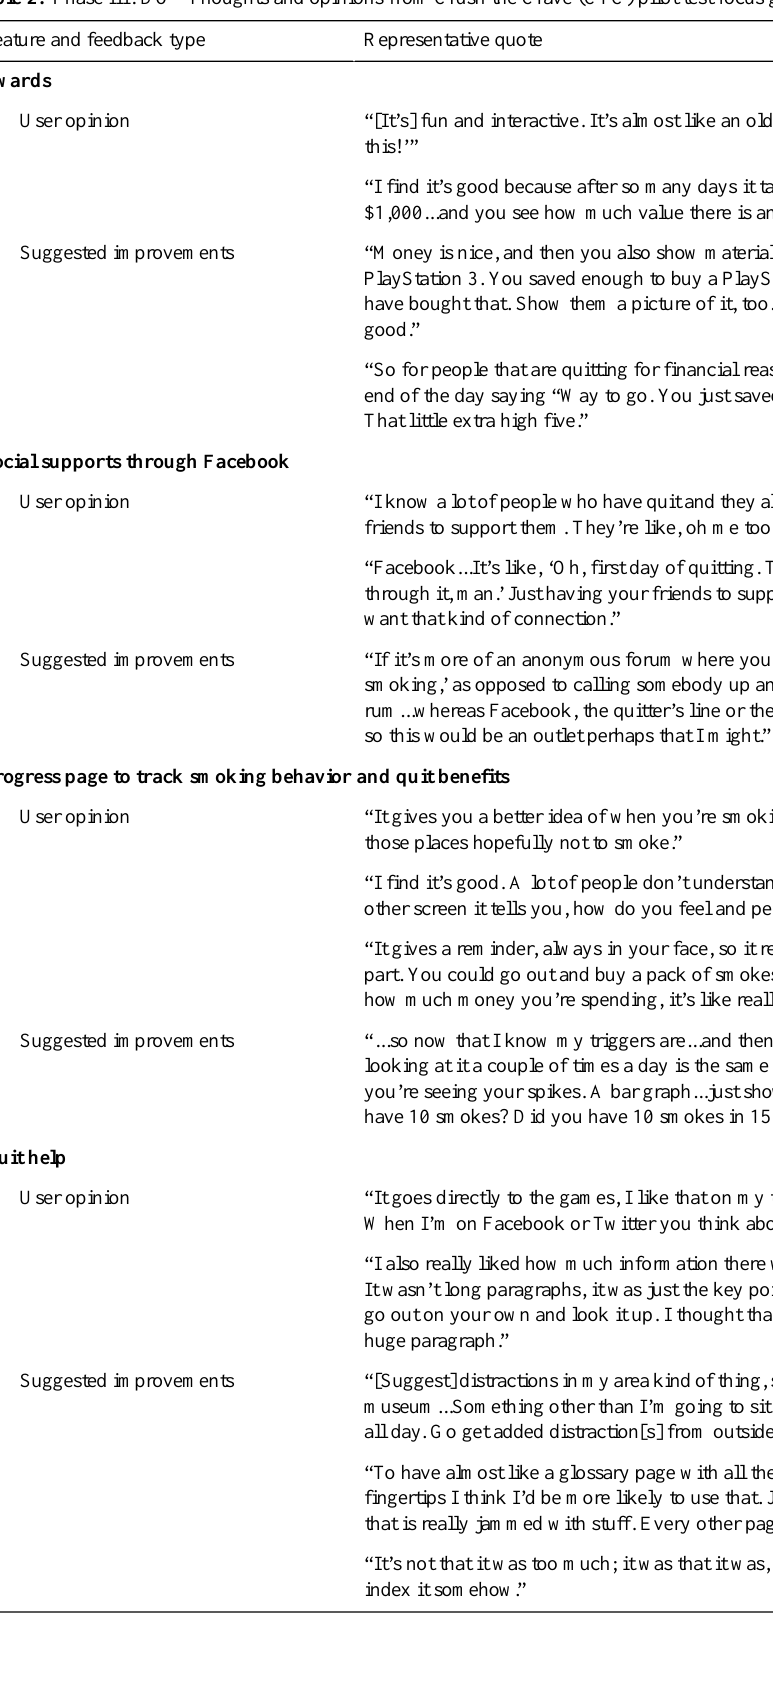
Table 2. Phase III: Do—Thoughts and opinions from Crush the Crave (CTC) pilot test focus groups.